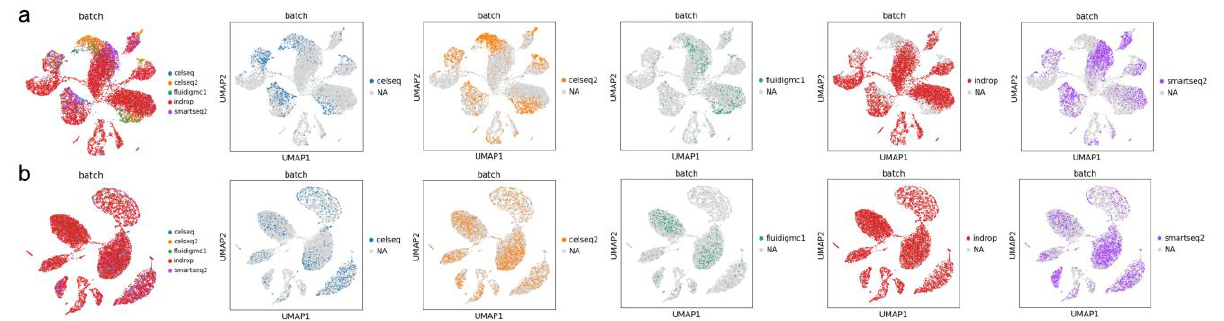
Figure 12. UMAP visualization of the distribution of each batch of the Pancreas dataset after IMAAE correction. ( a ) with steps 5 and 6, ( b ) without steps 5 and 6.